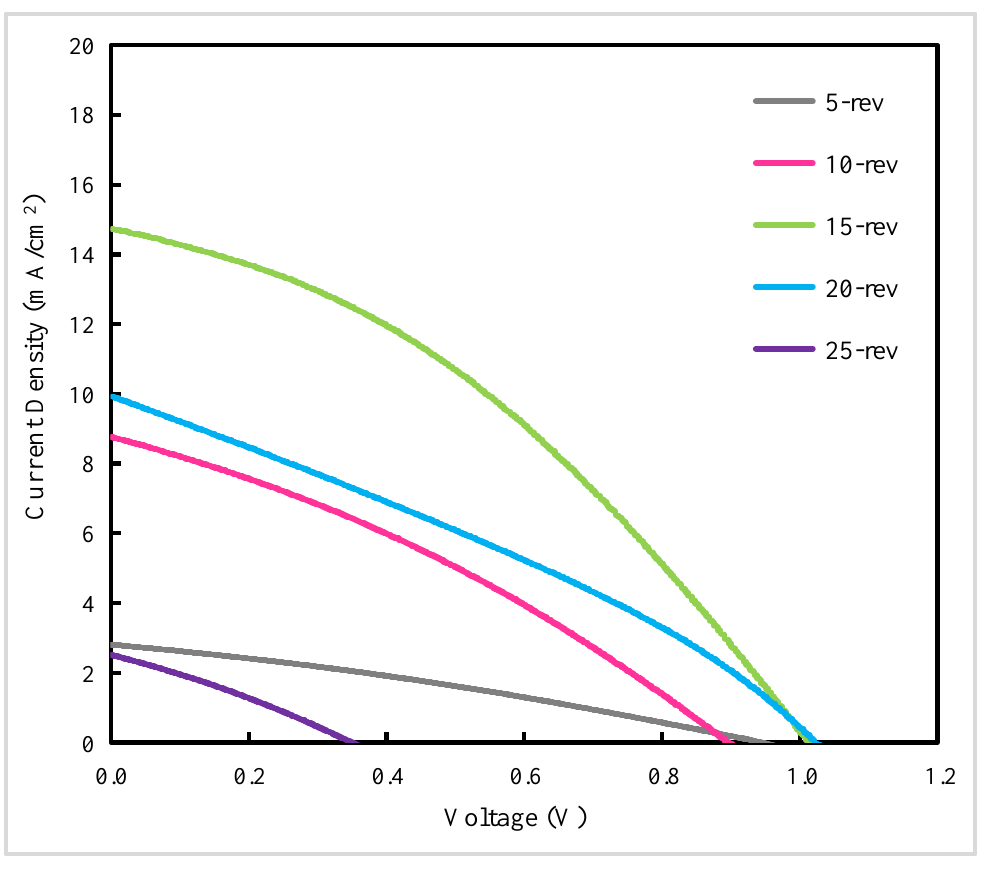
Figure 8. Reverse scanning J–V curves of perovskite solar cells optimized with different concentration of PC 61 BM. -rev represents reverse scanning. The number 5, 10, 15, 20, 25 represent different concentration of PC 61 BM. The device active area is 0.25 cm 2 (0.5 cm × 0.5 cm). Table 2. Data extracted from reverse scanning J–V curves of perovskite solar cells optimized with different concentration of PC 61 BM. -rev represents reverse scanning. The number 5, 10, 15, 20, 25 represent different concentration of PC 61 BM. The device active area is 0.25 cm 2 (0.5 cm × 0.5 cm).